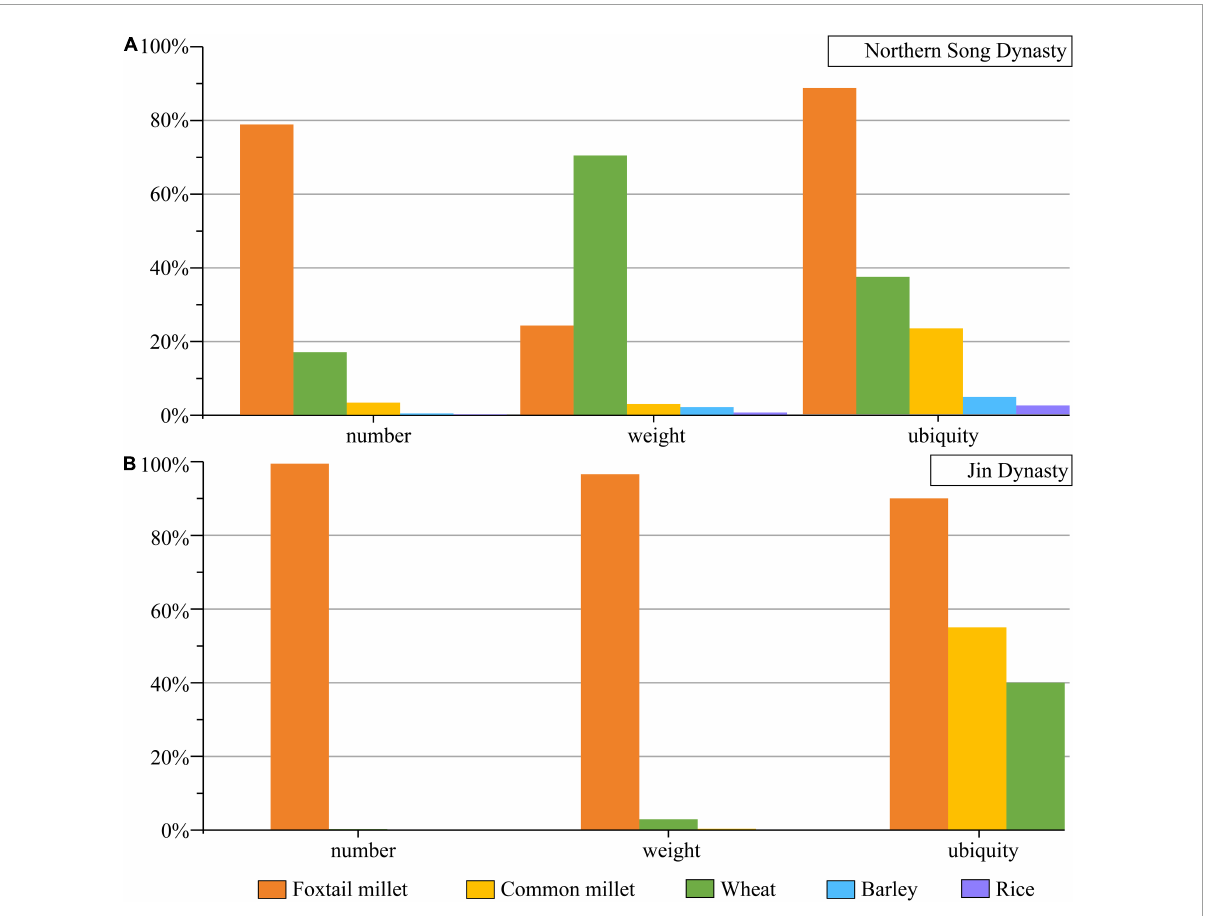
FIGURE5 Comparison of number proportion, weight proportion, and ubiquity of different crops in (A) Northern Song Dynasty and (B) Jin Dynasty in ZKS